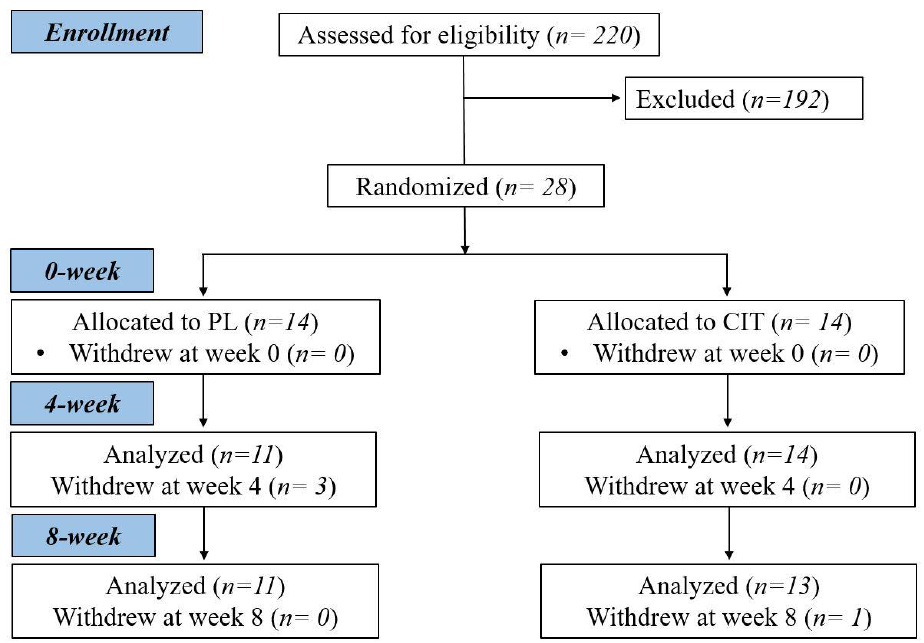
Figure 1. Study flow chart. CIT, L-citrulline; PL, placebo.